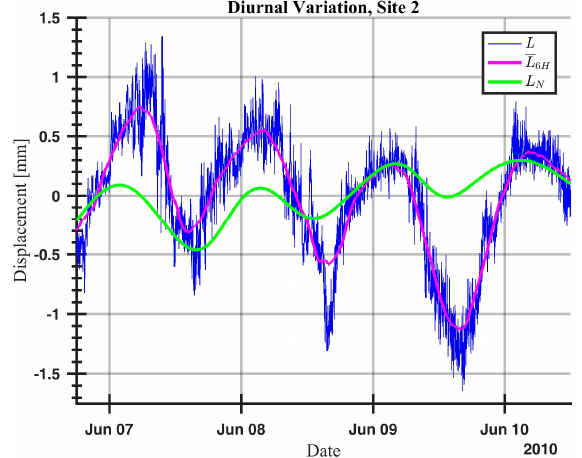
Figure 13. Diurnal variation in measured path length between the two reflectors at Site 2. The blue line is the raw data, the magenta line is the 6-h moving mean, and the green line is the calculated variation in the radio refractivity. As the plot shows, there is a good correlation between the measured path length variation and the calculated radio refractivity.